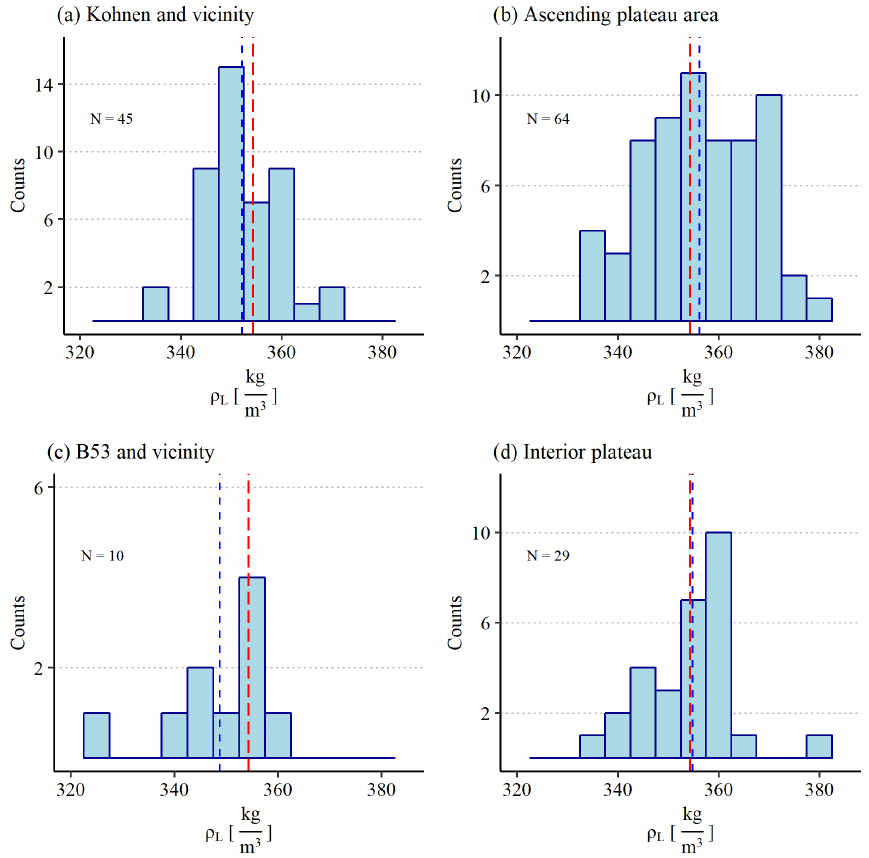
Figure 8. Histograms of the liner density ( ρ L ) for the four subregions (Fig. 1). The bin width for each histogram is 5kgm − 3 . The average ρ L (Fig. 6a) is given as a red dashed line while the liner density of the respective subregion is marked with a blue dashed